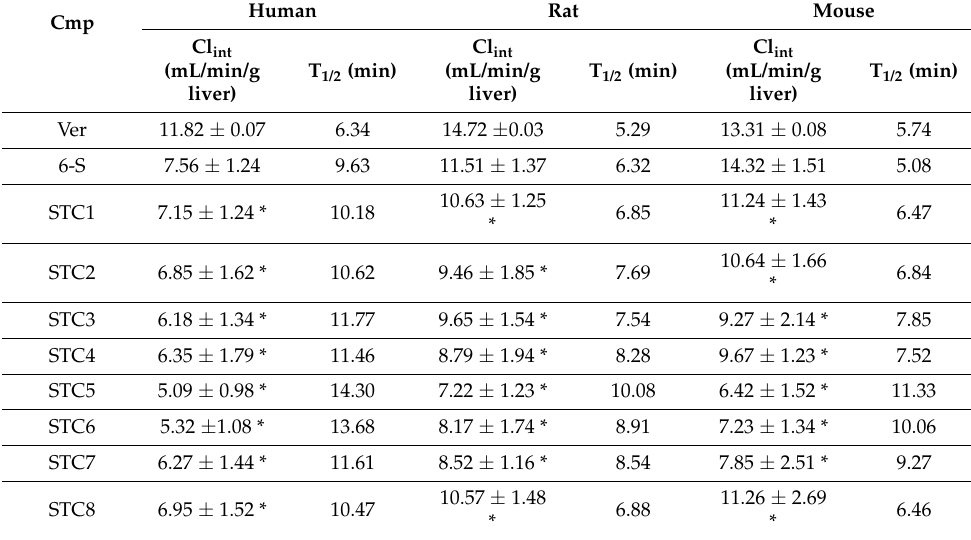
Table 2. The intrinsic clearance and half-life of 6-shogaol and STCs in liver microsomes.